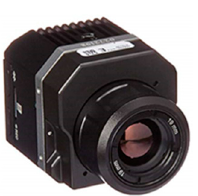
Figure 1. FLIR VUE PRO thermal camera.